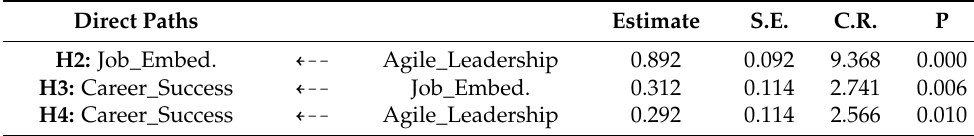
Table 4. Multiple regression weight and hypotheses